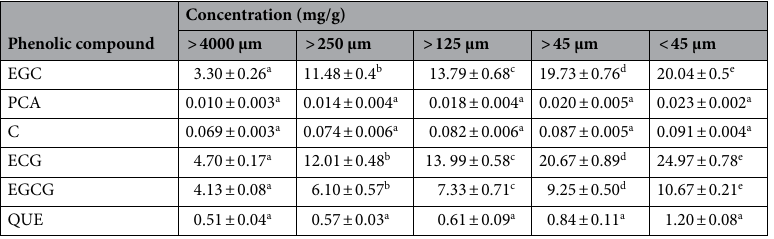
Table 2. Amounts (mg/g sample) of selected phenolic compounds ( EGC epigallocatechin; PCA protocatechuic acid; C catechin hydrate; ECG epicatechin gallate; EGCG epigallocatechin gallate; QUE quercetin) in S.cristaefolium extracts. Different letters indicating significant difference between columns (p <